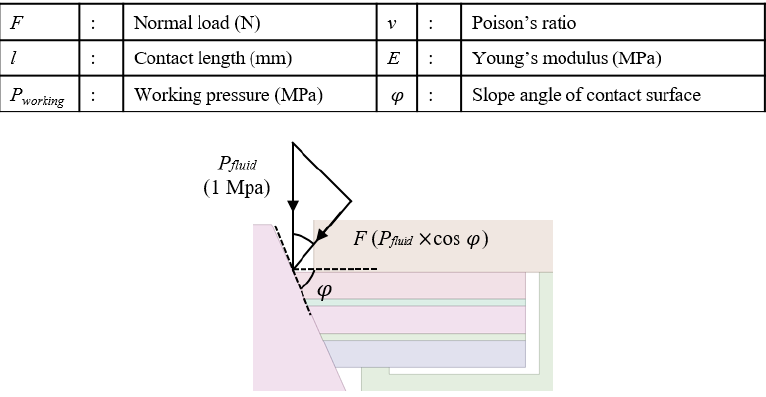
Figure 11. Scheme of normal load ( F ) acting on the contact surface.